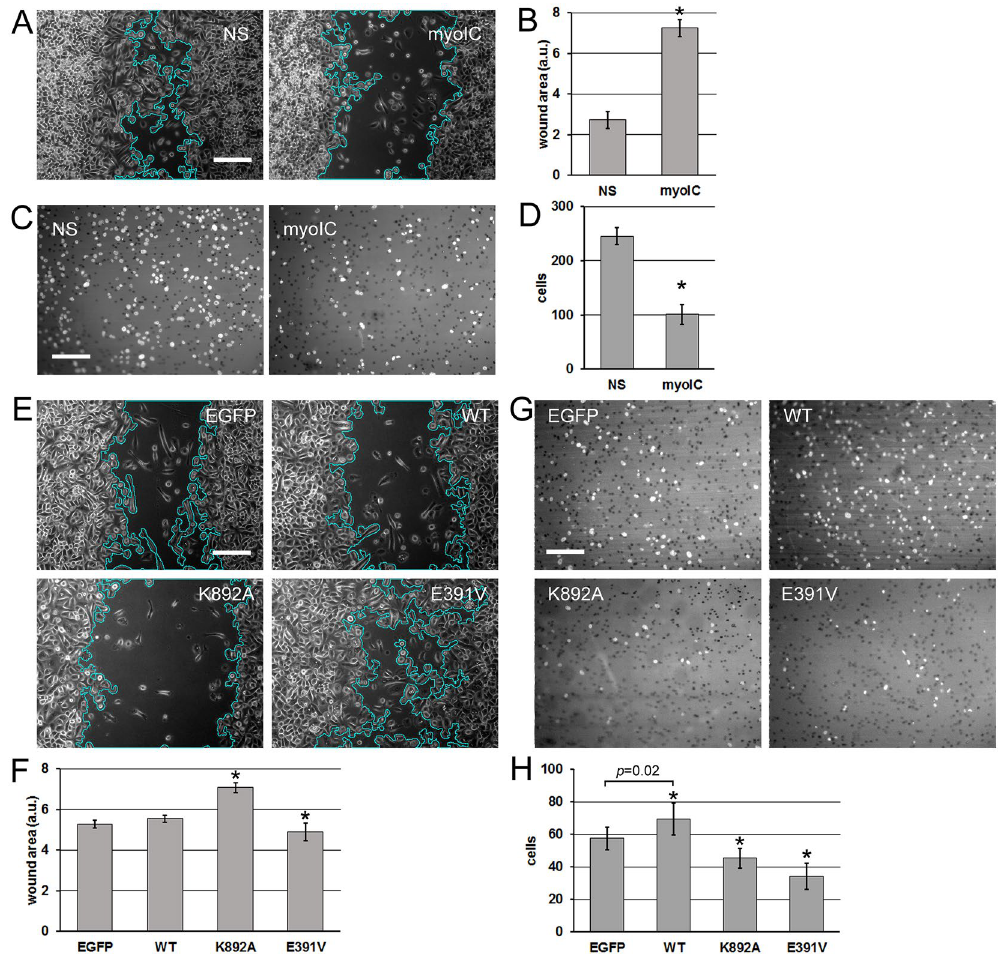
Figure 3. Effects of myosin IC and isoform A on motility and invasion of prostate cancer cells. ( A ) In-vitro wound closure experiment on PC3 with the siRNA knockdown. Scratched and healing cell monolayers were photographed in phase contrast 24 h after scratching. Representative fields are shown. Wound area outline in cyan is overlaid by the software used for the automated measurement. ( B ) Quantification of the experiment in A . Error bars: 95% c.i. on the mean. N = 40 camera fields per group. Experiment reproduced 4 times. ( C ) Matrigel invasion experiment on PC3 cells with the siRNA knockdown. Nuclei of cells that have invaded across the reconstituted extracellular matrix layer were visualized by DAPI staining and fluorescence microscopy. Representative fields are shown. ( D ) Quantification of the experiment in ( C ). Error bars: 95% c.i. on the mean. N = 36 camera fields per group. Experiment reproduced 4 times. ( E ). In-vitro wound closure experiment on PC3 cells expressing the isoform A constructs or EGFP as the treatment control. Visualization as in ( A ). ( F ) Quantification of the experiment in ( E ). Error bars: 95% individual c.i. on the mean. N = 52 camera fields per group. Experiment repeated 4 times. ( G ) Matrigel invasion experiment on PC3 cells expressing the isoform A constructs. Visualization as in ( C ). ( H ) Quantification of the experiment in ( G ). Error bars: 95% individual c.i. on the mean. * Significant (p < 0.05) deviations from the control. One-tailed p-values in pairwise comparisons with the EGFP control are: WT – indicated on the graph, K892A – 0.005, E391V – < 0.0001. If regarded as a multiple comparison, each null hypothesis of equality to the control is rejected on the familywise significance level 0.05 using the Holm-Bonferroni correction. Scale bars in ( A , E , C , G ) – 200 µ